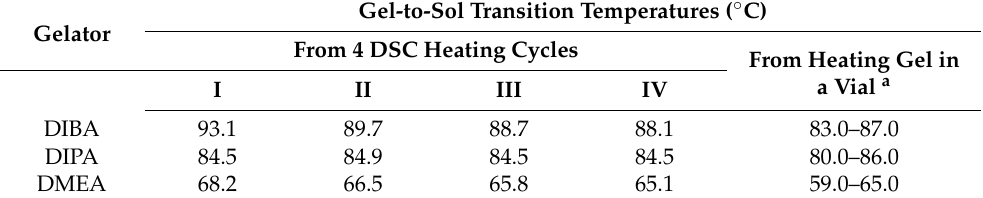
Table 3. Gel-to-sol transition temperatures ( ◦ C) from melting of 3 wt% silicone oil gels in a vial and from the peak maxima from DSC thermograms (4 cycles) of the